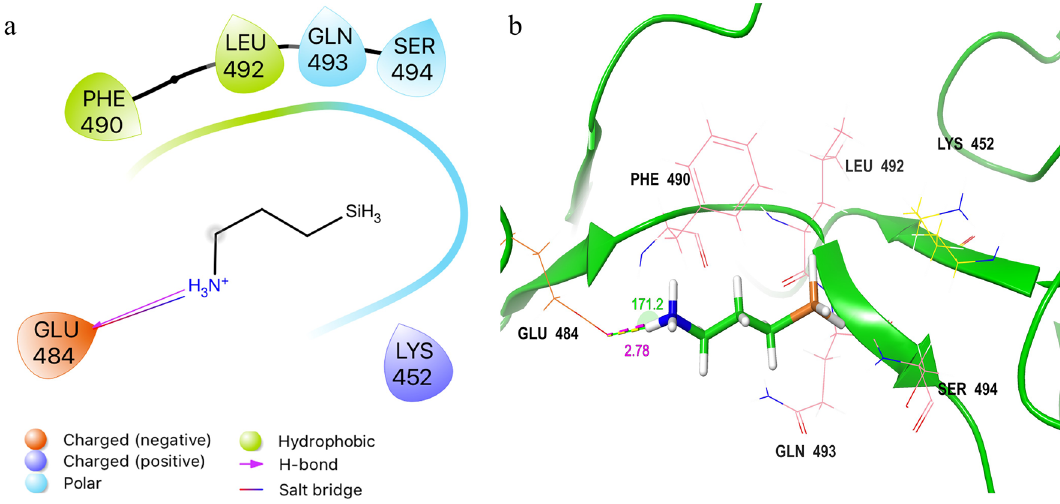
Figure 5. The 2D ( a ) and 3D ( b ) interaction diagrams of the docked APS ligand against the RBD domain of the spike protein. Interacted residues were labeled. The hydrogen bond is shown in